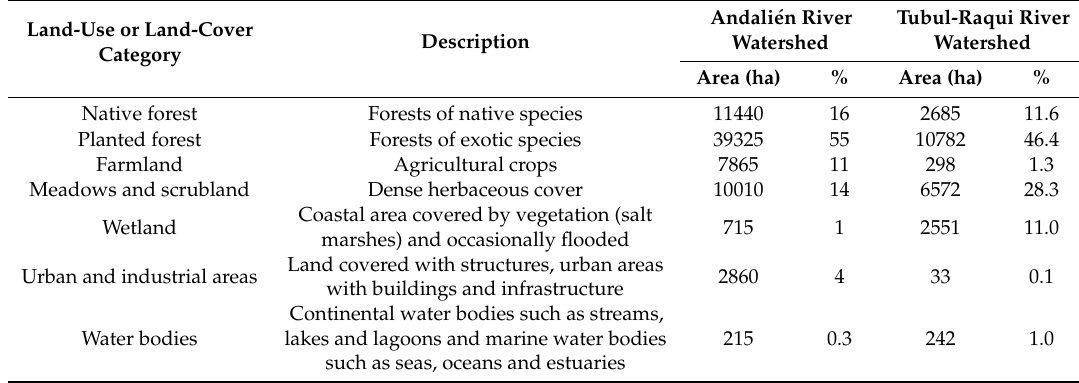
Table 1. Land-use categories